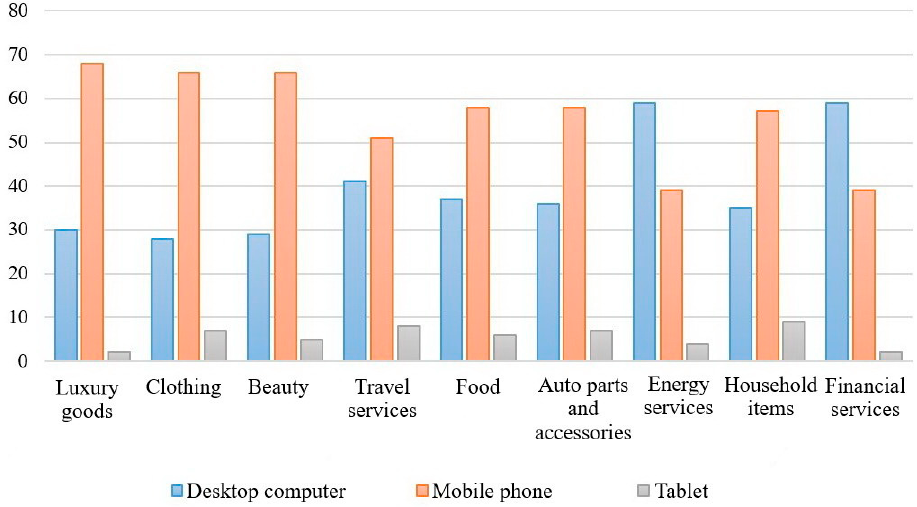
Figure 3. Percentage of web traffic from desktop computers, mobile devices, and tablets in 2019 by industry. Source: adapted from [49,50].